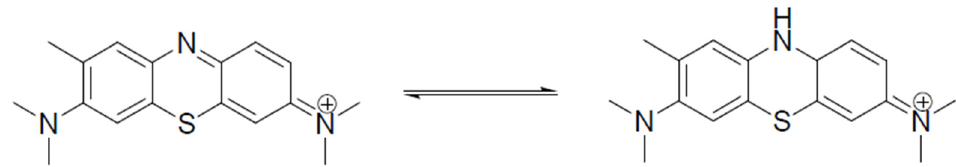
Figure 1. Discolouration of the Toluidine Blue dye (based on Figure 1 from [32]).